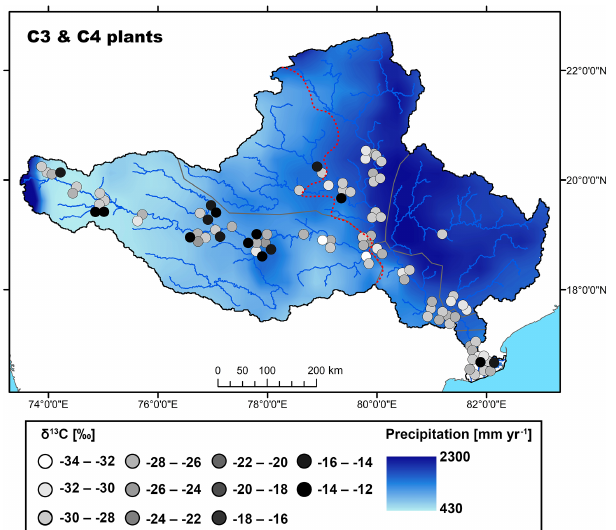
Figure 3. Box-and-whisker plot of δ 13 C ( org ) values measured in C 3 and C 4 plants, soils, SPM, and riverbed sediments collected in the dry and wet season in the upper and lower Godavari basin. The box represents the first ( Q 1 ) and third ( Q 3 ) quartiles, and the line in the box represents the median value; the whiskers extend to 1 . 5 · (Q 3 − Q 1 ) values, and outliers are shown as points. Outcomes of the two- way ANOVA are indicated for plants, soils and SPM, and those of non-parametric tests (Mann–Whitney and Kruskal–Wallis) are for the sediments. The level of significance is as follows: NS for not significant, ∗ for p ≤ 0 . 05, ∗∗ for p ≤ 0 . 01 and ∗∗∗ for p ≤ 0 . 001.